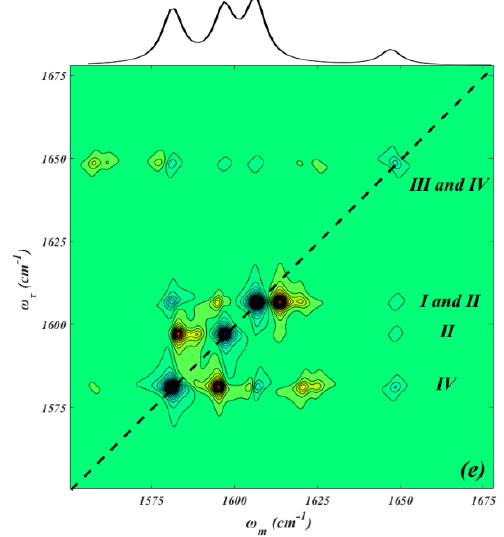
Figure 2. Normalized and simulated quasi-static 2D IR spectra and the corresponding IR spectra (top panel) of NO 2 asymmetric stretching vibrations at different E-fields (V/nm). E-fields: ( a ) − 2.0568; ( b ) − 1.0284; ( c ) 0; ( d ) 1.0284; ( e ) 2.0568. Roman numbers represent the vibration modes in the corresponding DNTF molecules.